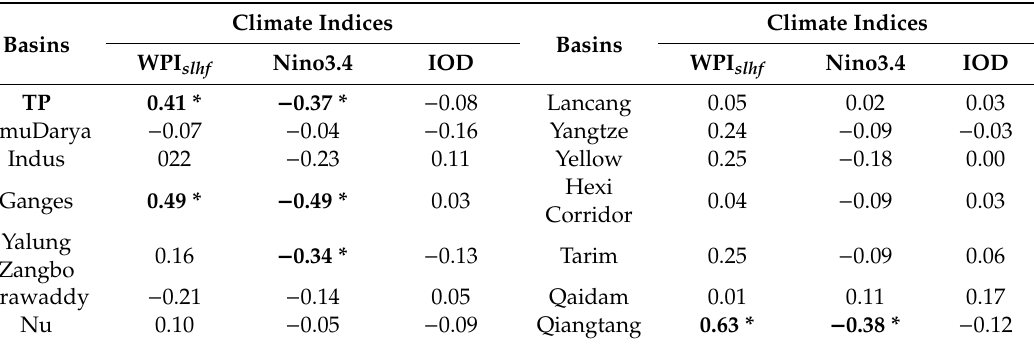
* The bold values are statistically significant above the 95%